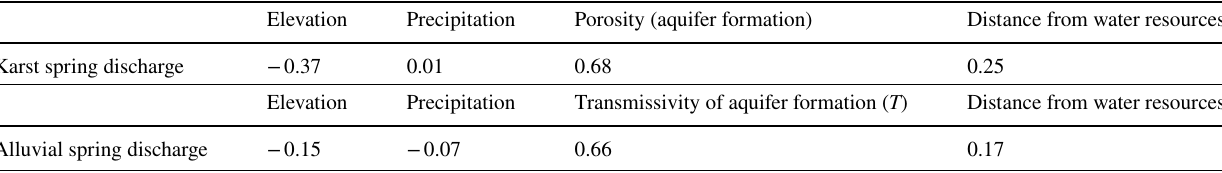
Table 1 Correlation between springs discharge and their effective factors